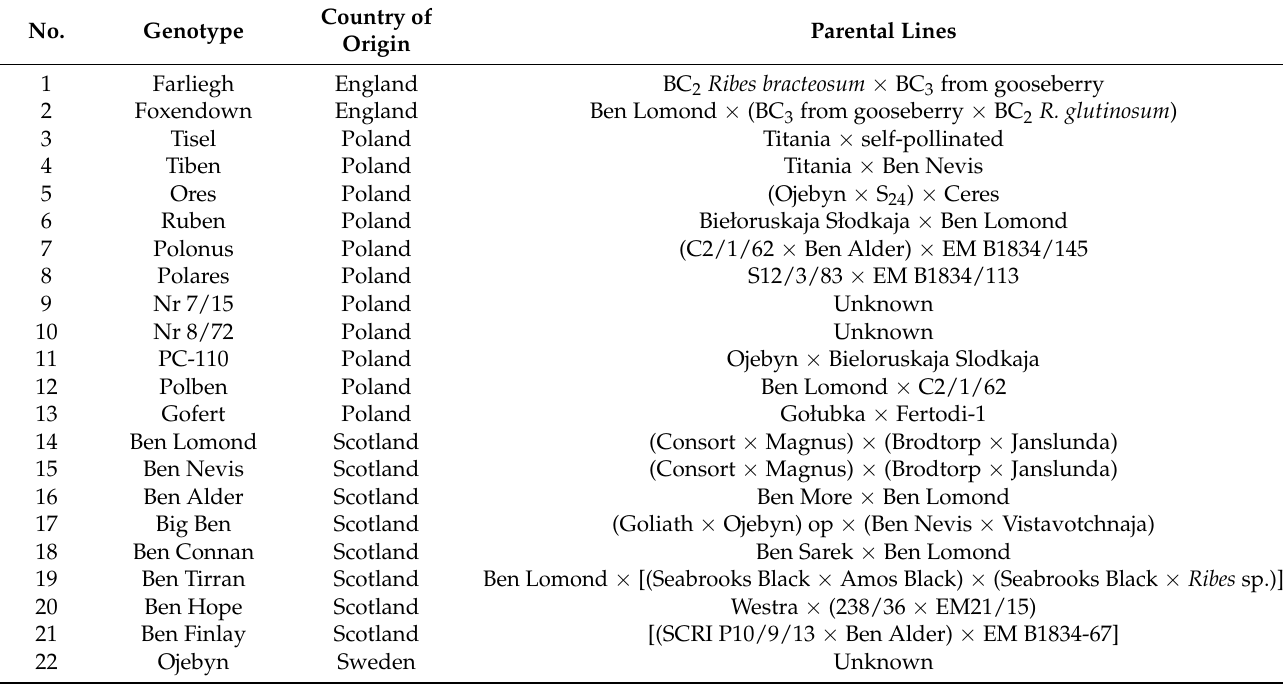
Table 1. List and origin of blackcurrant genotypes evaluated in the